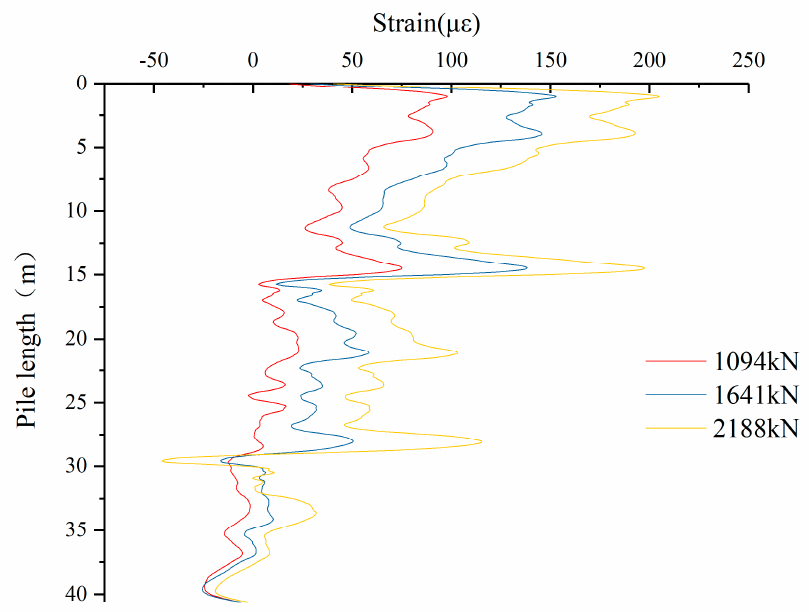
Figure 4. Signal reconstruction after denoising.